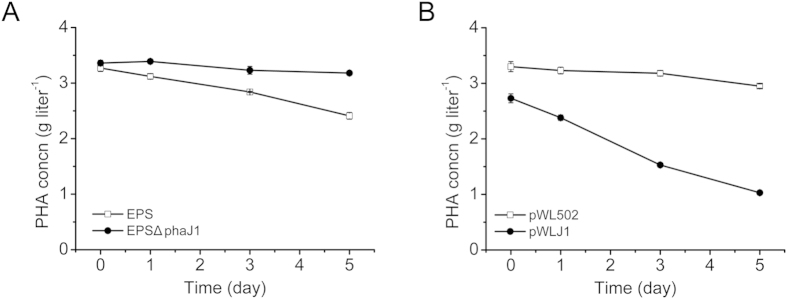
Effect of phaJ1 deletion (A) and complementation (B) on PHA mobilization in H. mediterranei. EPS, H. mediterranei EPS; EPSΔphaJ1, H. mediterranei EPSΔphaJ1. pWL502, H. mediterranei EPSΔphaJ1 harboring empty plasmid; and pWLJ1, H. mediterranei EPSΔphaJ1 harboring expression plasmid of phaJ1 with its promoter region.